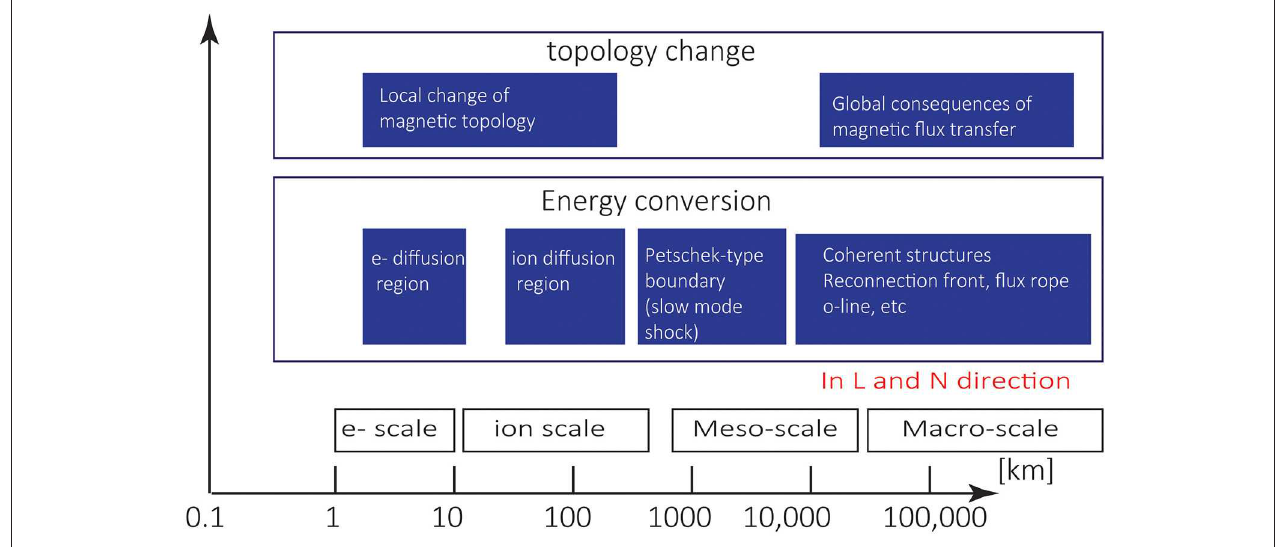
FIGURE 5 | Science questions of AME mission. Spatial scales of physical processes in the energy conversion and topology changes in